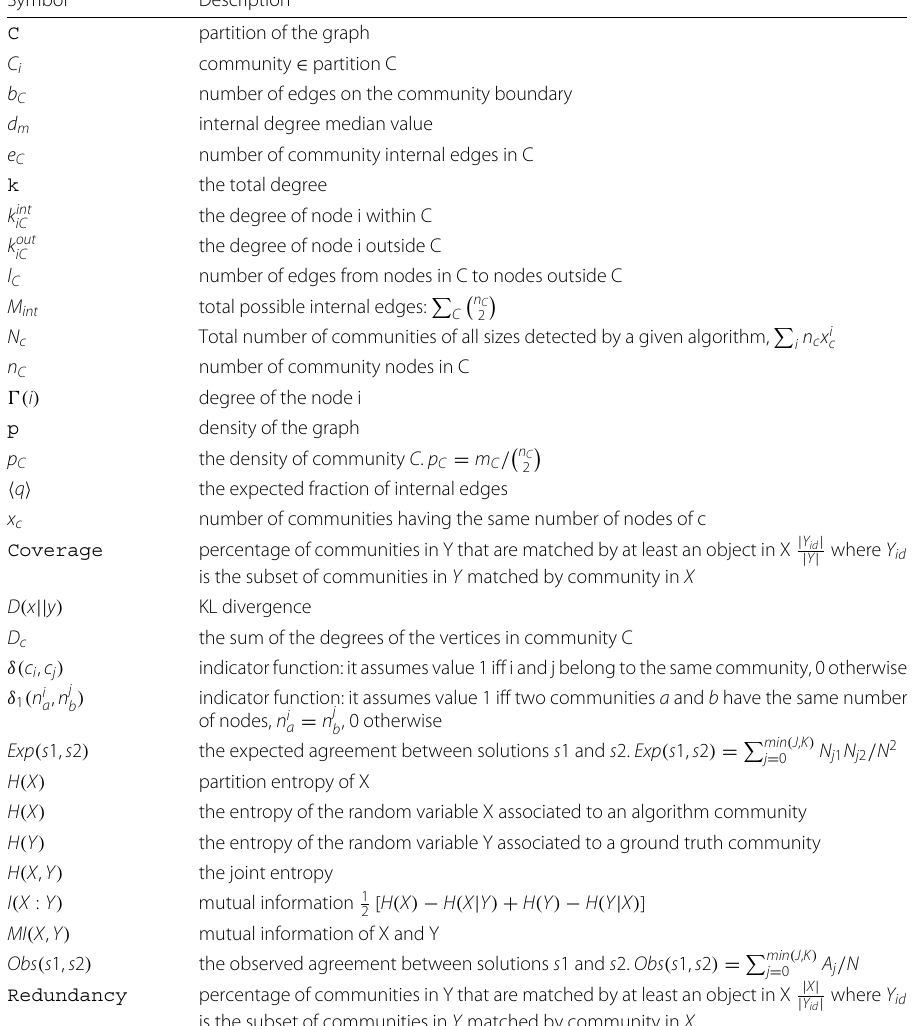
Table 2 Description of the symbols used in the formulas for fitness and comparison functions Symbol